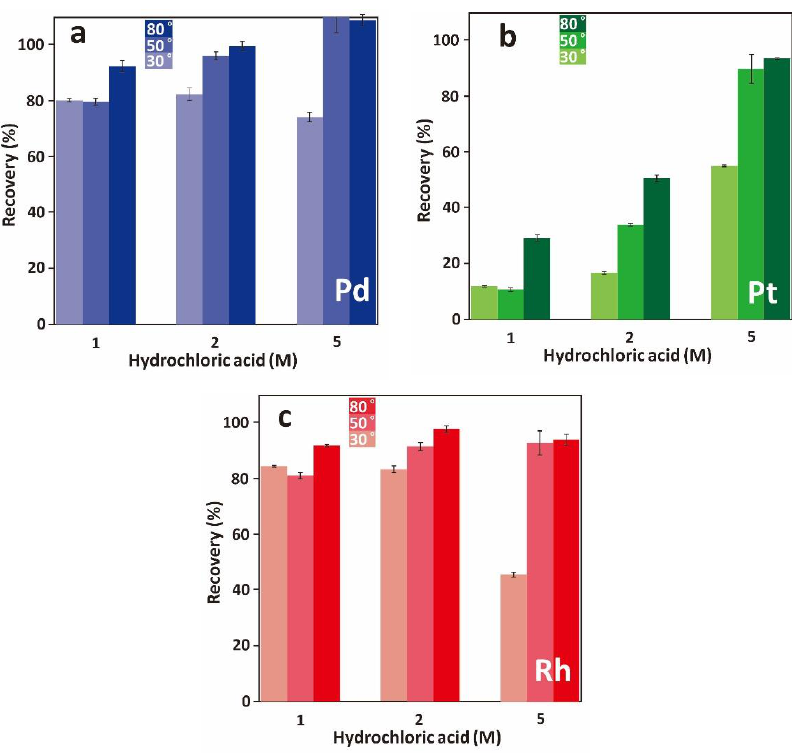
Figure 9. PGE recovery as a function of different hydrochloric acid concentrations and leaching temperatures ( a ) Pd, ( b ) Pt, and ( c ) Rh.